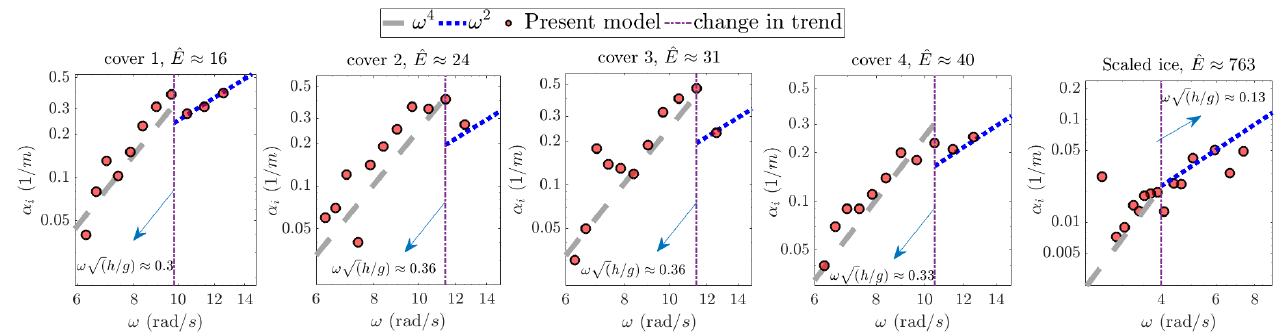
Figure 18. Decay rates as a function of wave frequency. Panels show the data found using the present model.